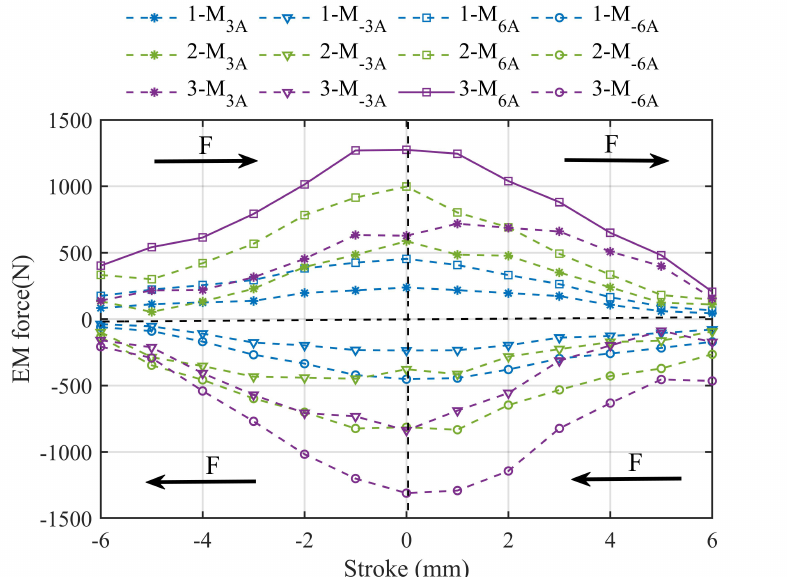
Figure 12. Thrust force of the proposed TMM-LOA under static conditions at different stroke